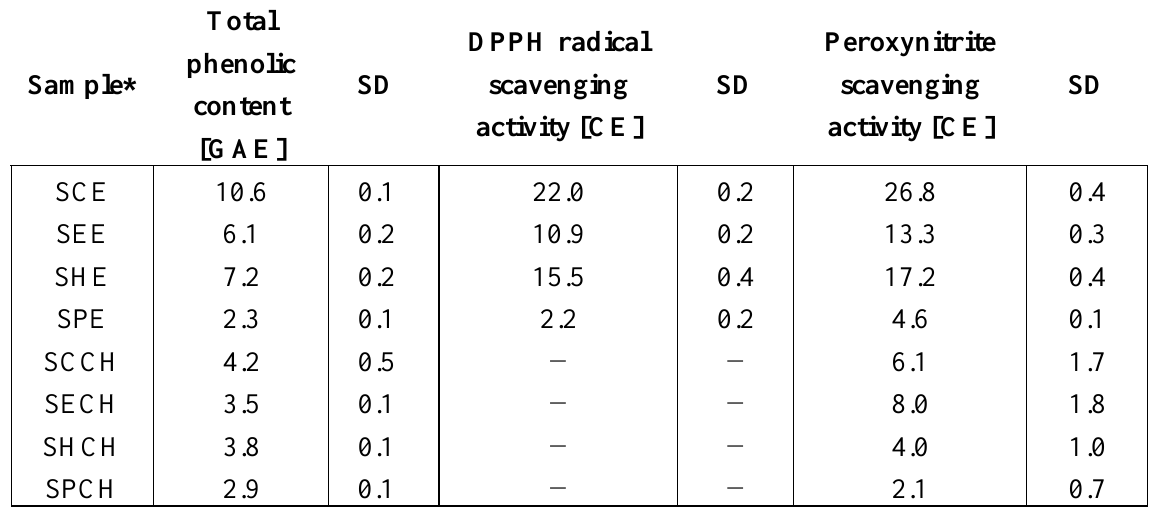
Table 1. Total phenolic content and antioxidant activities of Staphylea L.